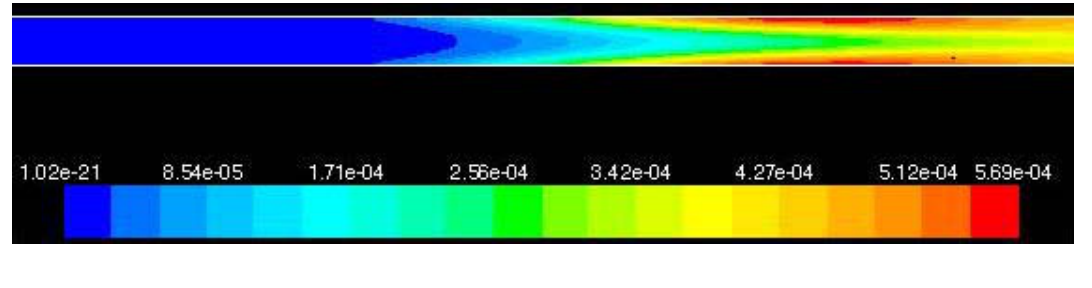
at 900 °C and 20 mbar partial pressure of acetylene. (s)